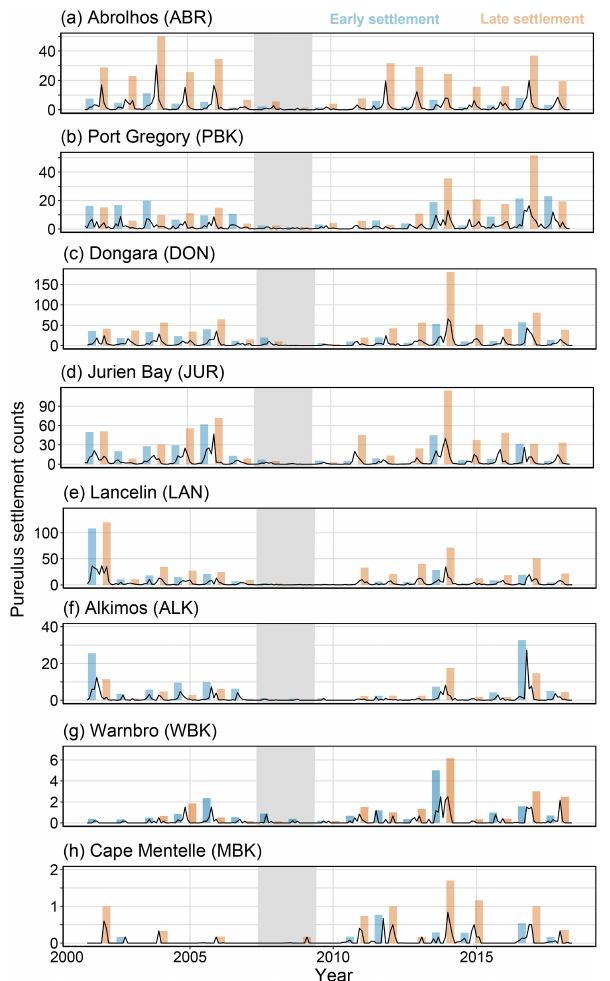
Figure 4. Monthly average puerulus counts for each monitor- ing site (black line) with the early (May–October, blue) and late (November–April, red) puerulus settlement for the season. The in- dex is a sum of the included monthly average puerulus counts. Grey shaded seasons (2008 and 2009) indicate the less-than-expected PI based on a priori relationships (Caputi et al., 2001).